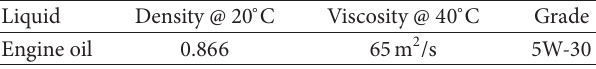
Table 1: Properties of liquid used in